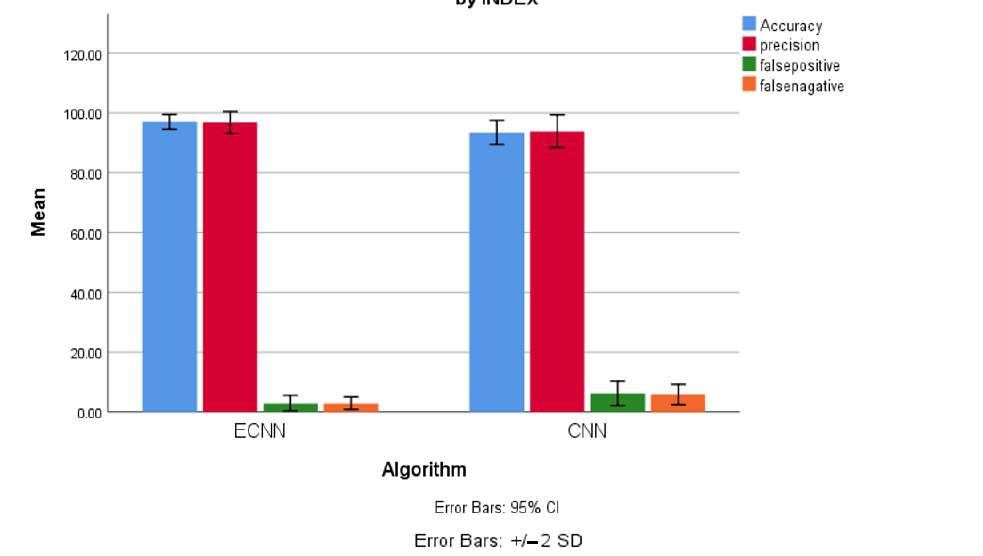
Figure 11. Performance comparisons between ECNN and CNN.